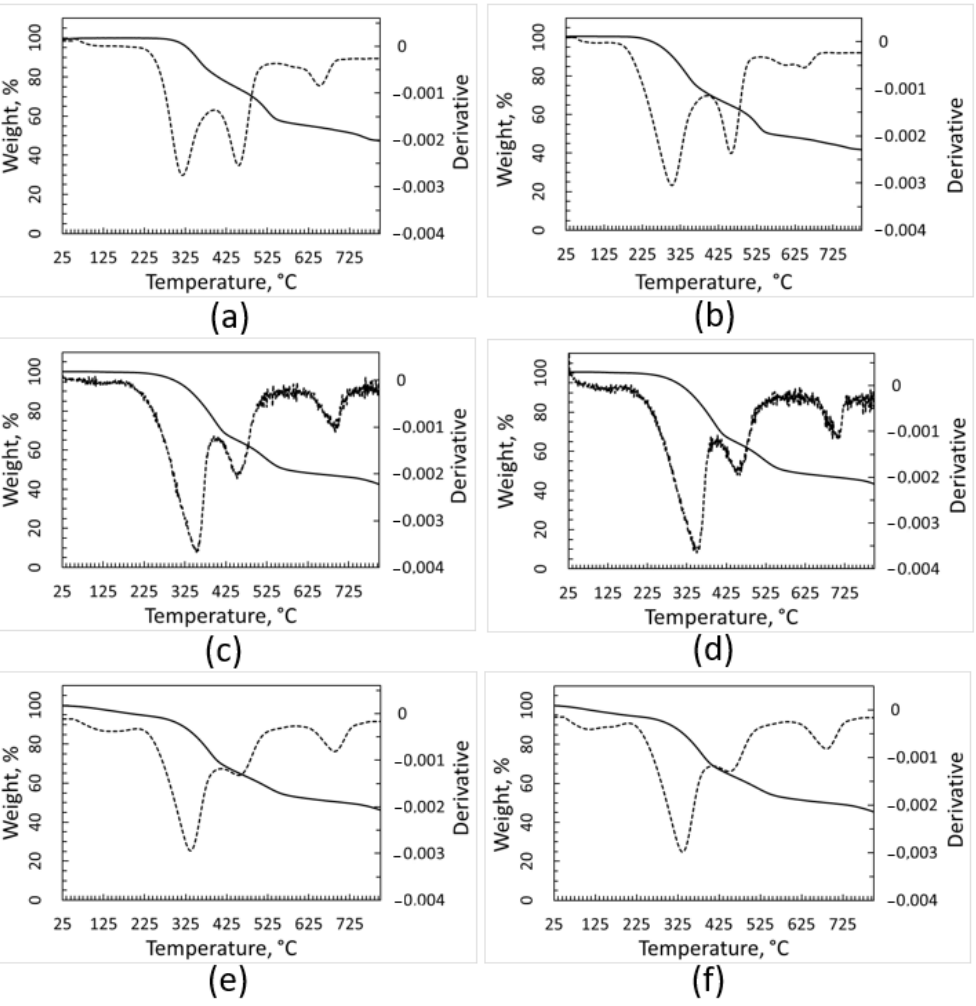
Figure 3. TGA and DTGA (dotted line) curves of contaminants removed from plastic batches. Curves recorded under inert atmosphere: PE ( a ), PP ( c ) and PET ( e ). Curves recorded under air, PE ( b ), PP ( d ), and PET ( f ).